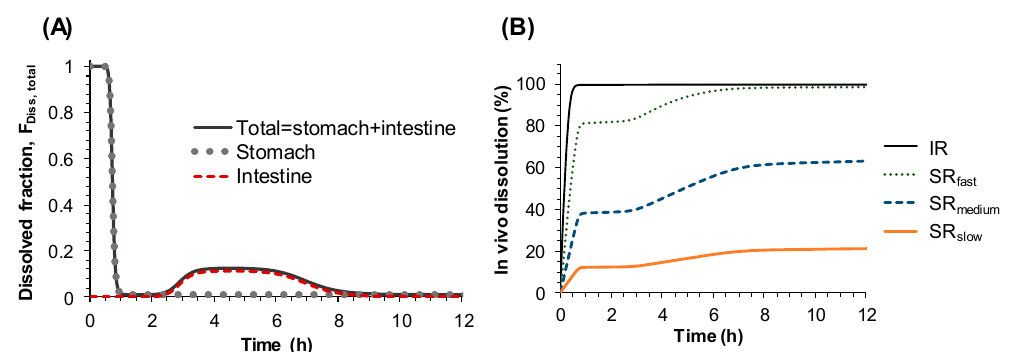
Figure 4. Model-estimated ( A ) dissolved fraction (F Diss, total ) and ( B ) in vivo dissolution of sildenafil (%) from IR and SR tablets.